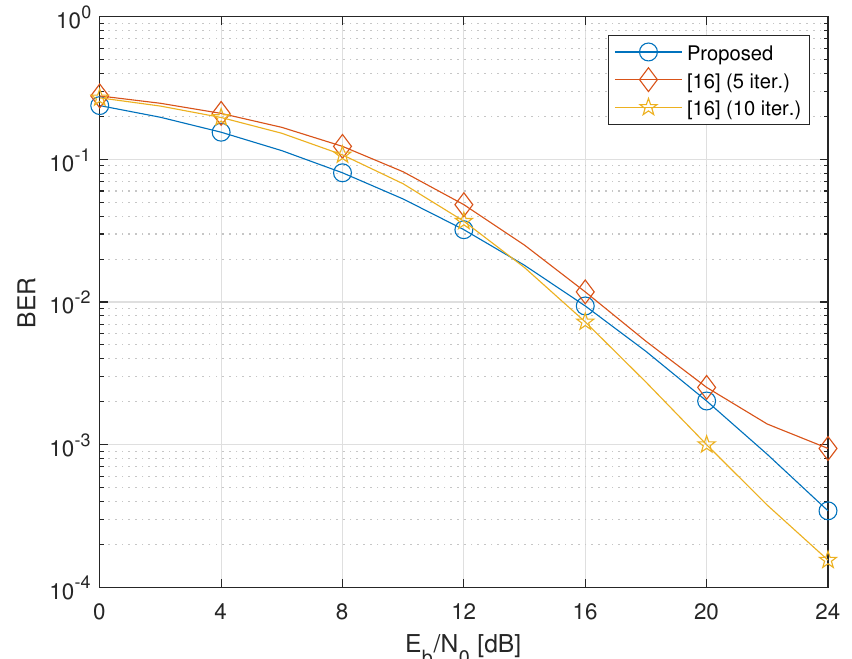
Figure 2. Bit-error-rate (BER) versus E b / N 0 of the proposed design versus the iterative method of Reference [16] ( N C = 2).